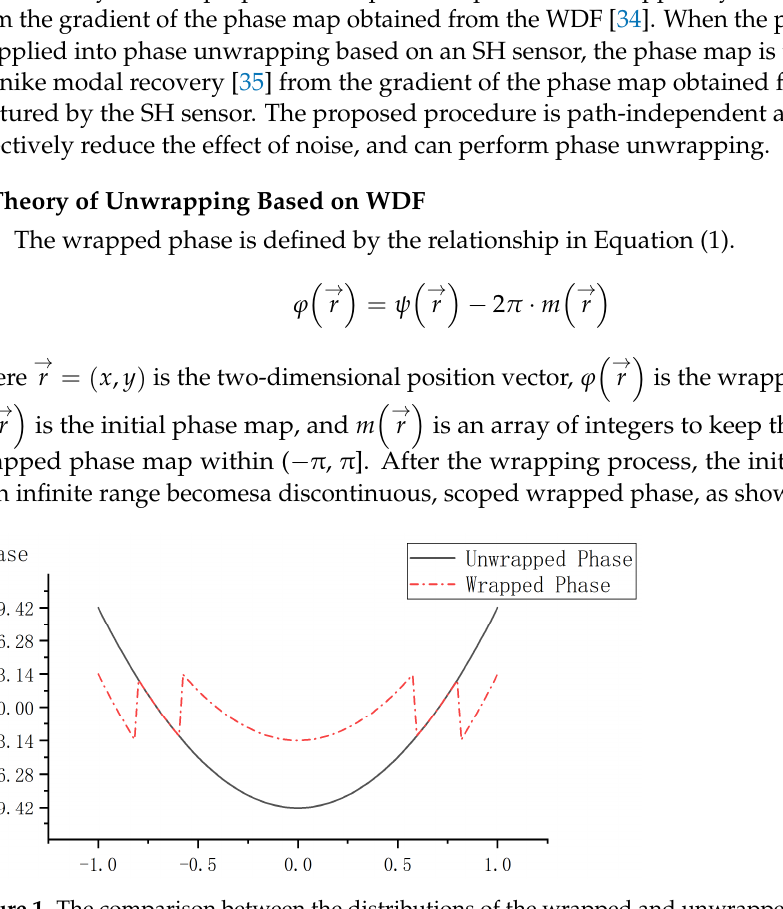
Figure 1. The comparison between the distributions of the wrapped and unwrapped phase map.